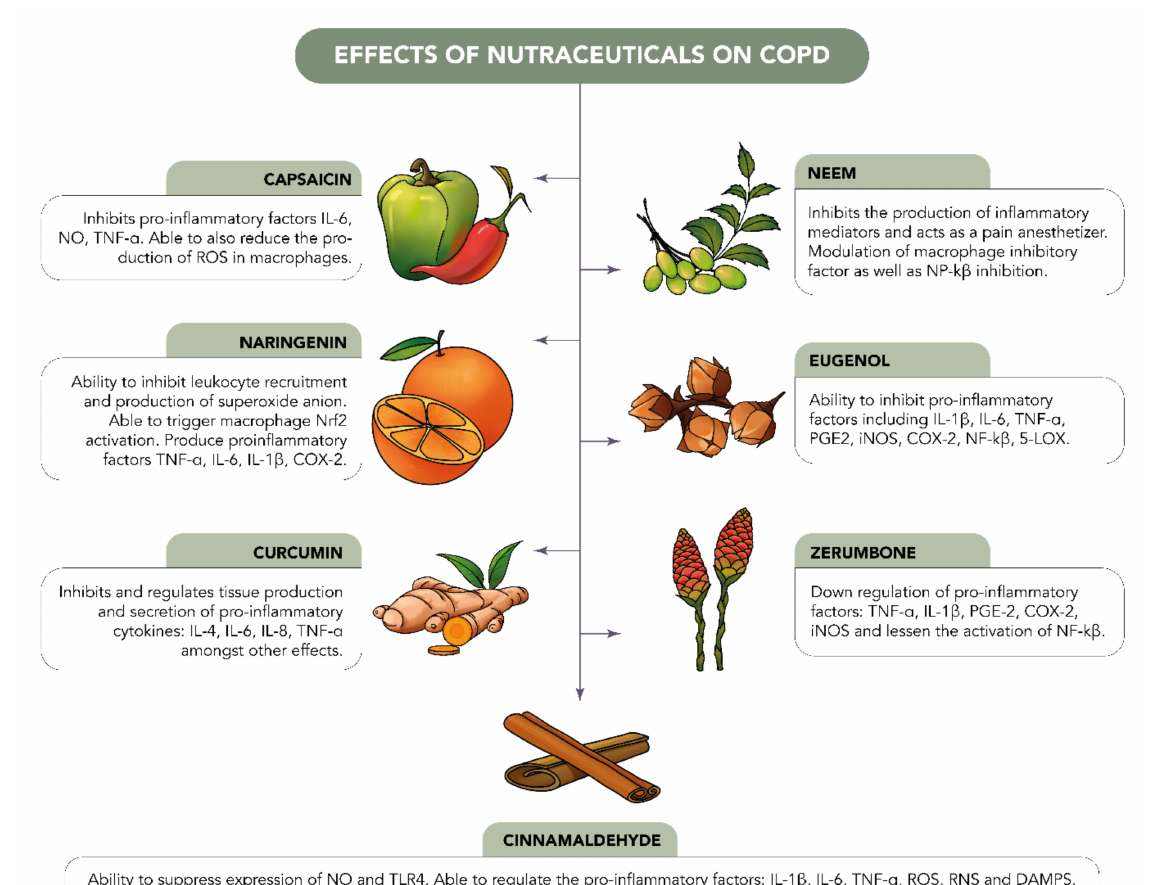
Figure 3. The effects of various nutraceuticals on lung inflammation and